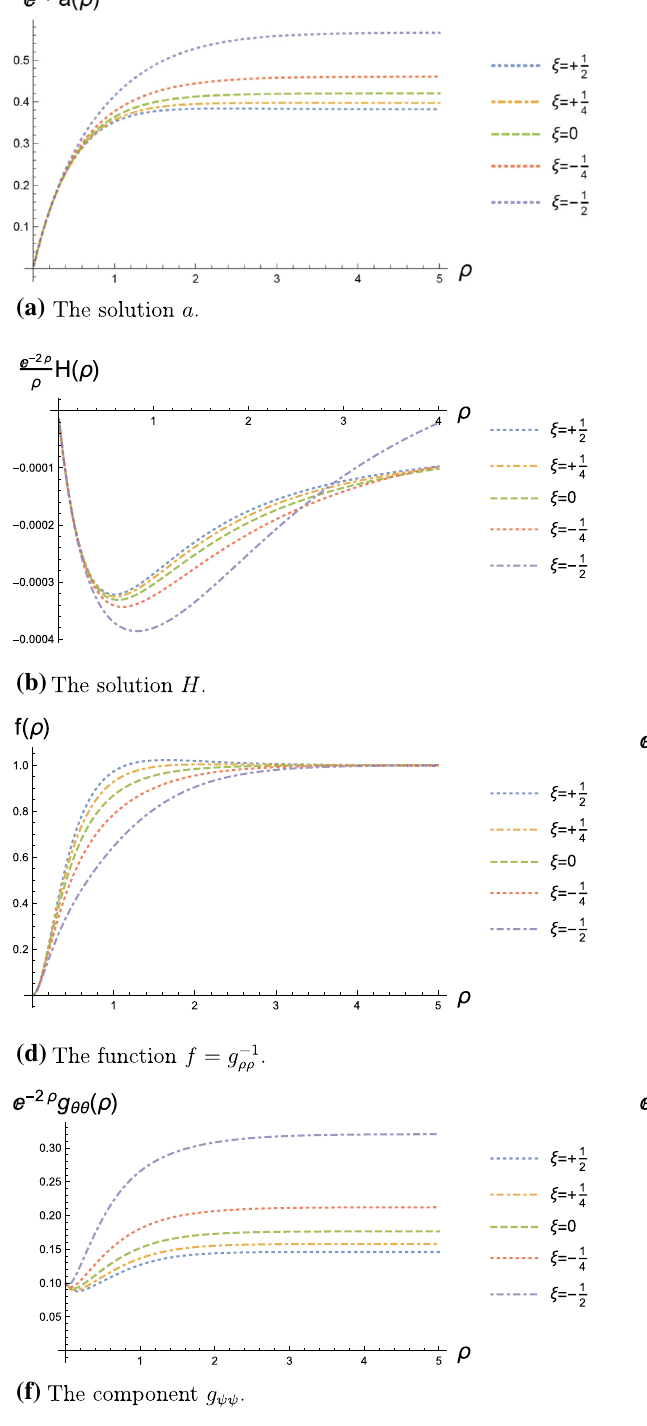
Fig. 4 Relevant functions and metric components of our solution for α = 0 . 84, (cid:14) = + 0 . 008 and different values of ξ , reported in the label. Each function is rescaled by its asymptotic behavior at large ρ .